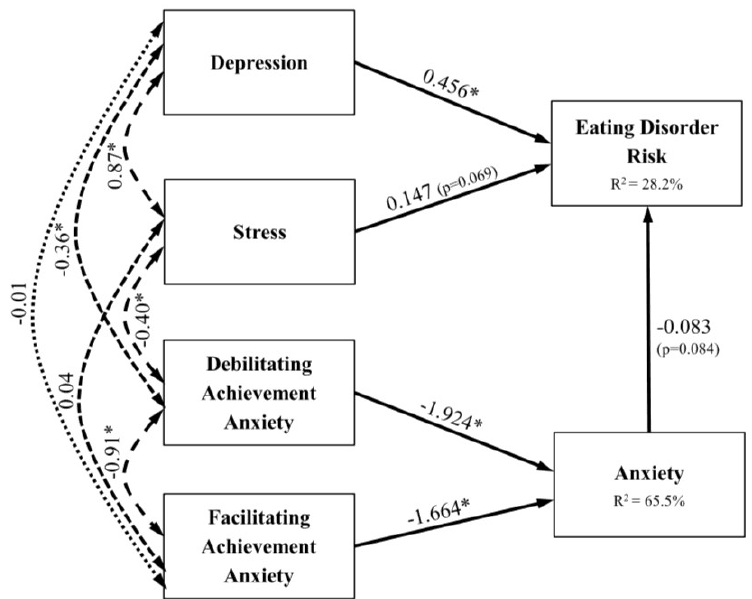
Figure 2. Path model leading to eating disorders risk. Paths from independent to dependent variables depict standardised estimates and double arrows indicate correlations; * p < 0.001.